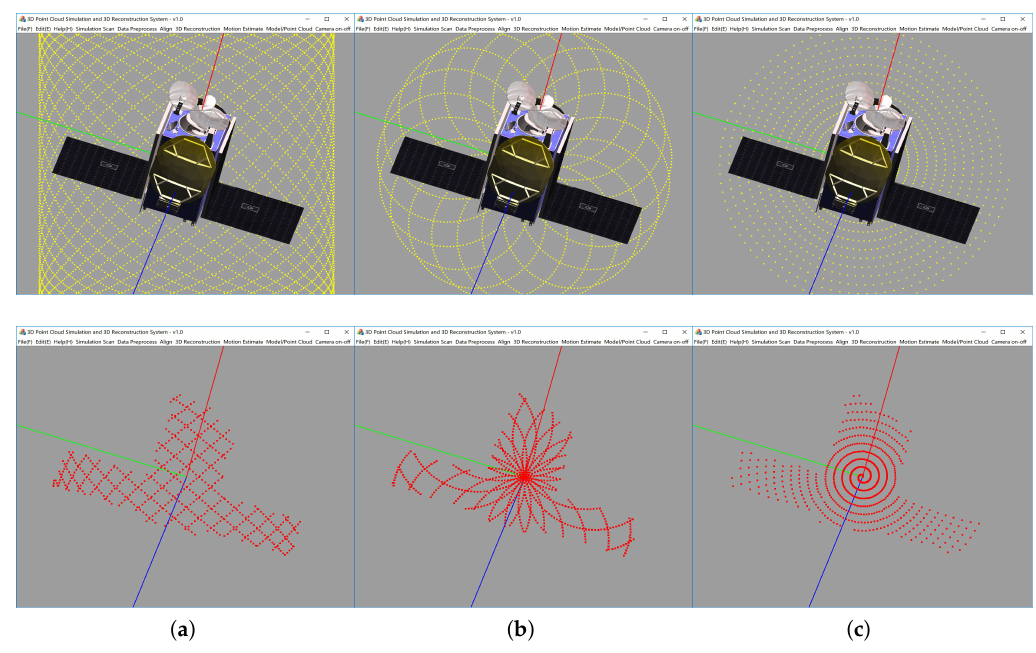
Figure 8. The 3D point cloud simulation software ( a ) Lissajous, ( b ) Rosette, ( c )